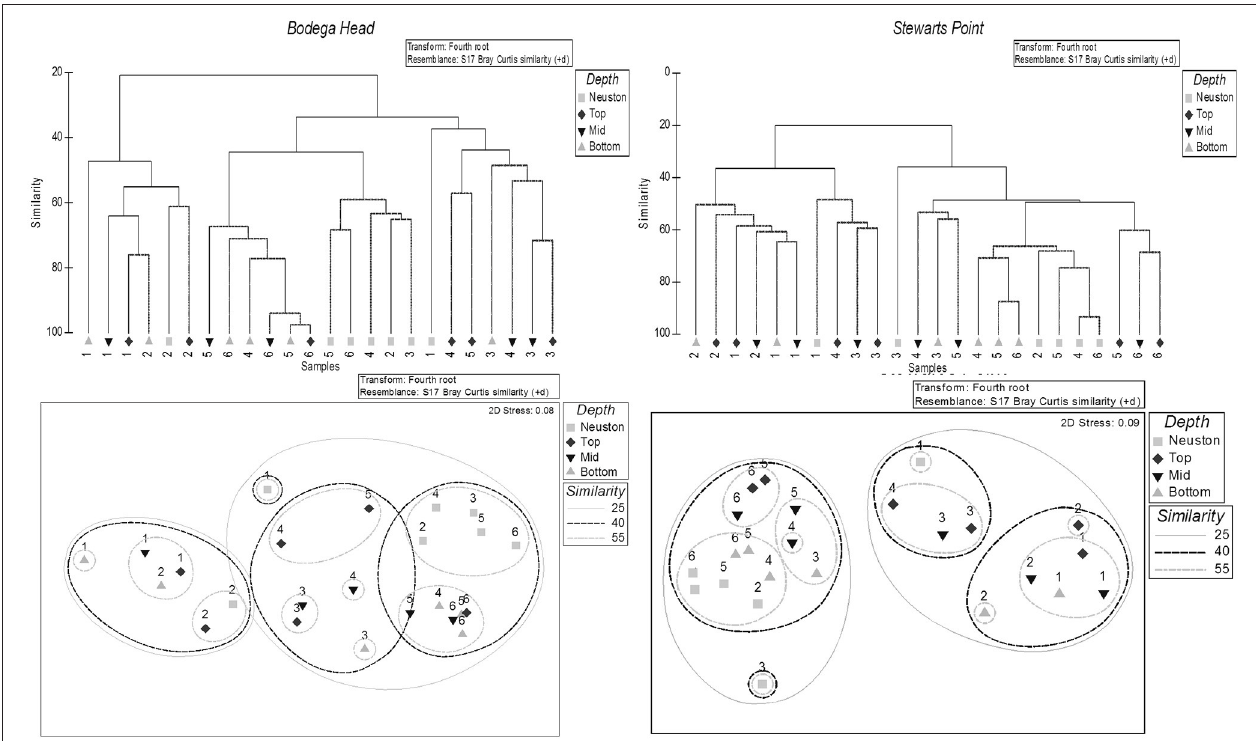
FIGURE 7 | Top panels. Hierarchical clustering dendrogram (using group-average linking) of 48 samples taken from four depths at six sampling stations across the continental shelf: 1, 6, 11, 32, and 63km from shore off Bodega Head and 1, 3, 10, 20, 30, and 49km from shore off Stewarts Point. Samples were categorized based on 25 and 40% similarities. Solid black lines indicate significant group structure at the 1% level. Sample distances offshore are reported beneath each group. Bottom panels: Nonmetric multidimensional scaling plots (2D stress: 0.08 for Bodega Head and 0.09 for Stewarts Point) from the 48 samples with superimposed significant clusters at similarity levels of 25% (solid lines) and 40% (dashed lines) off Bodega Head and Stewarts